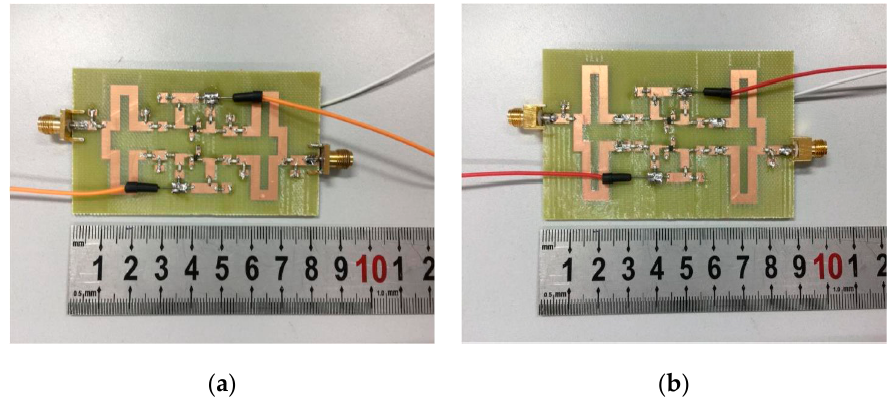
Figure 7. Photograph of ( a ) traditional matching BDLNA (bi-directional low noise amplifier) and ( b ) proposed matching BDLNA.